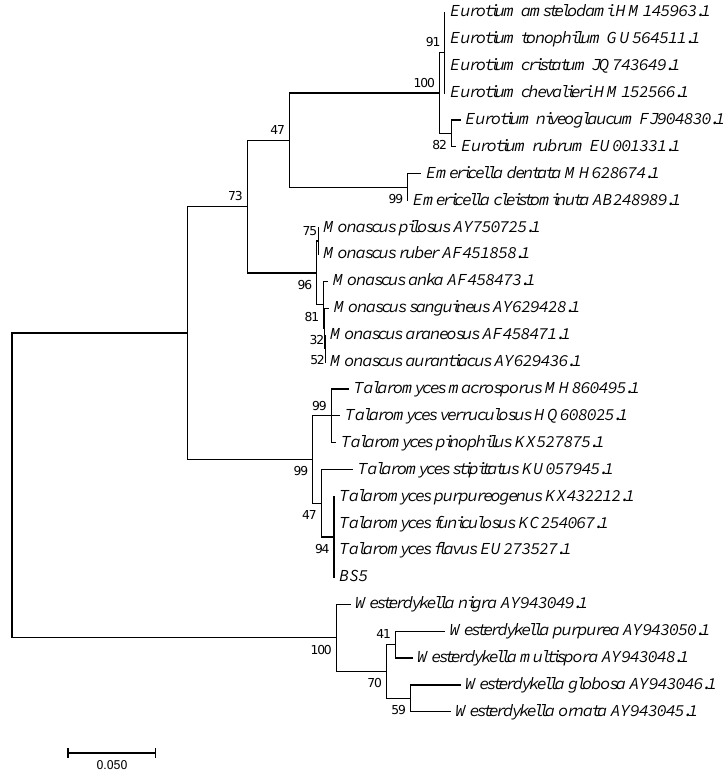
Figure 6. The Maximum Likelihood method phylogram yielded from ITS sequence data set.